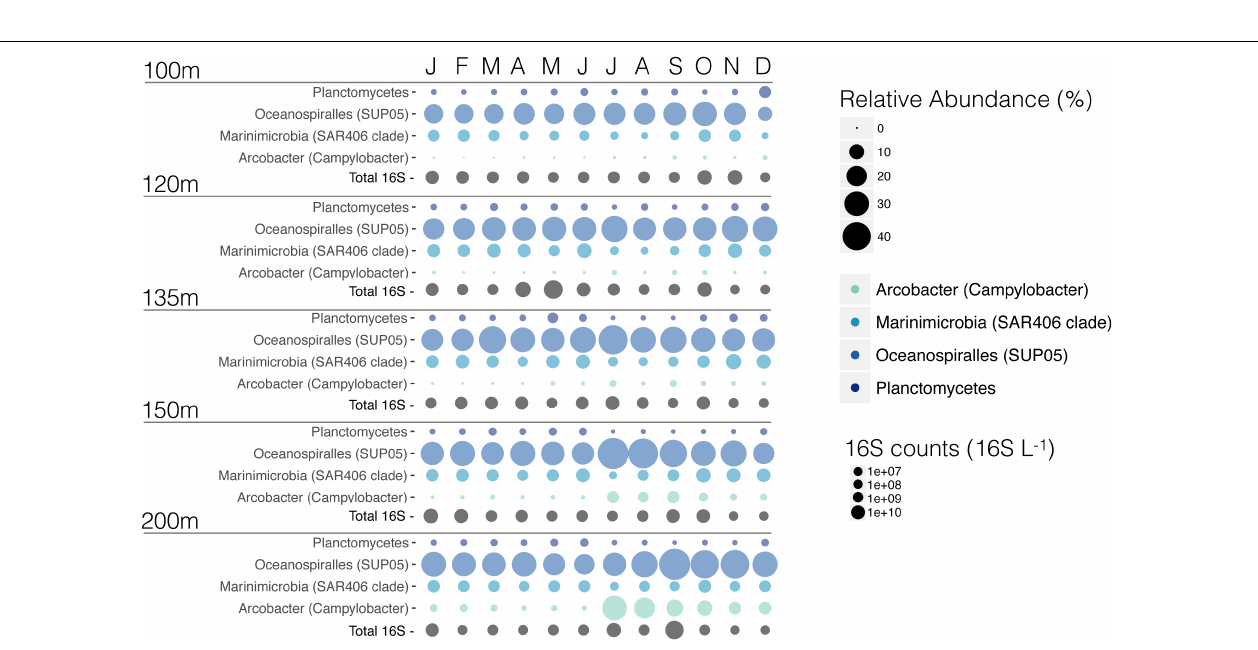
FIGURE 9 | Comparison of the relative abundance of Planctomycetes, SUP05 cluster, Marinimicrobia, and newly highlighted Arcobacter bacteria. In addition to the relative abundance of these clades, we added total 16S counts (16S L − 1 ) for each of these samples.